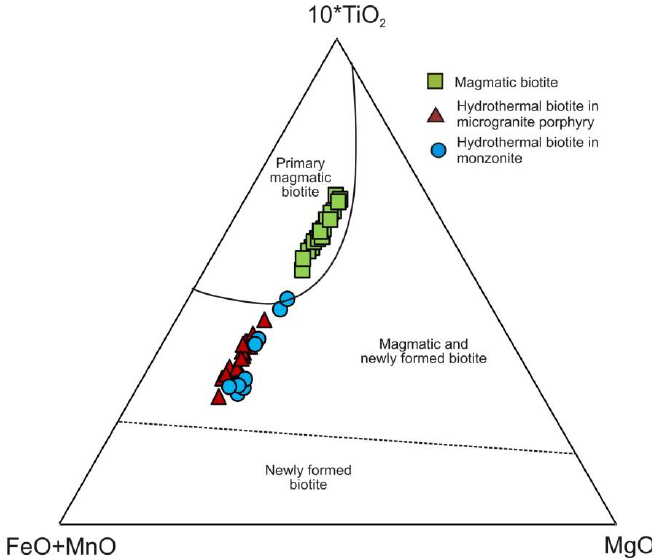
Figure 7. Ternary 10 × TiO 2 -(FeO + MnO)-MgO composition of magmatic biotites from the monzonite and secondary biotites from the potassic alteration of the monzonite and the microgranite porphyry in Maronia. The discrimination field boundaries are from Nachit et al. [46]. Total iron as FeO.